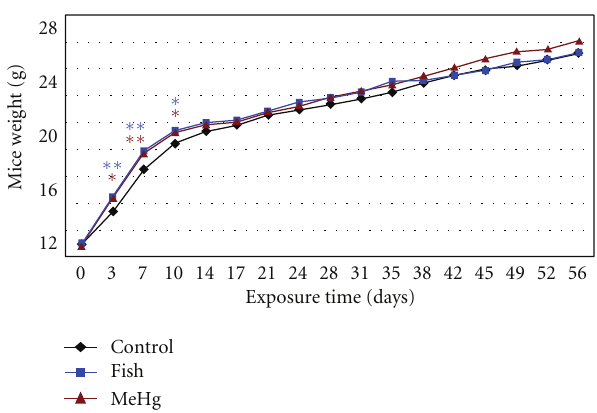
Figure 1: Influence of diet on the body weight growth. Mice were exposed to a control diet (“Control” plot with black diamonds), or a MeHg-containing diet (“MeHg” plot with red triangles), or a fish- containing diet (“Fish” plot with blue squares). Weights (in grams) were collected at the indicated kinetic time points and the mean weights plotted. Means and standard deviations were calculated from 16 control-, MeHg- and fish-fed mice from the beginning to the 35th day. From days 38 to 56, they were calculated from 8 animals per diet. The asterisks indicate a significant di ff erence in body weight for mice fed the MeHg- and fish-containing diet compared to those fed the control diet, as determined with a one- way ANOVA followed by a Dunnett’s multiple comparison method, ∗ P < 0 . 05, and ∗∗ P < 0 .